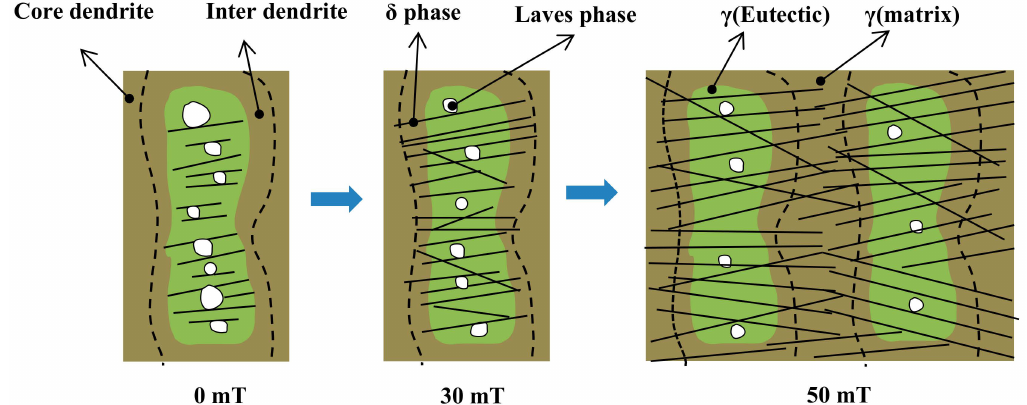
Figure 12. Schematic diagram of the e ff ect of micromagnetic field intensity on the morphology and distribution of the δ